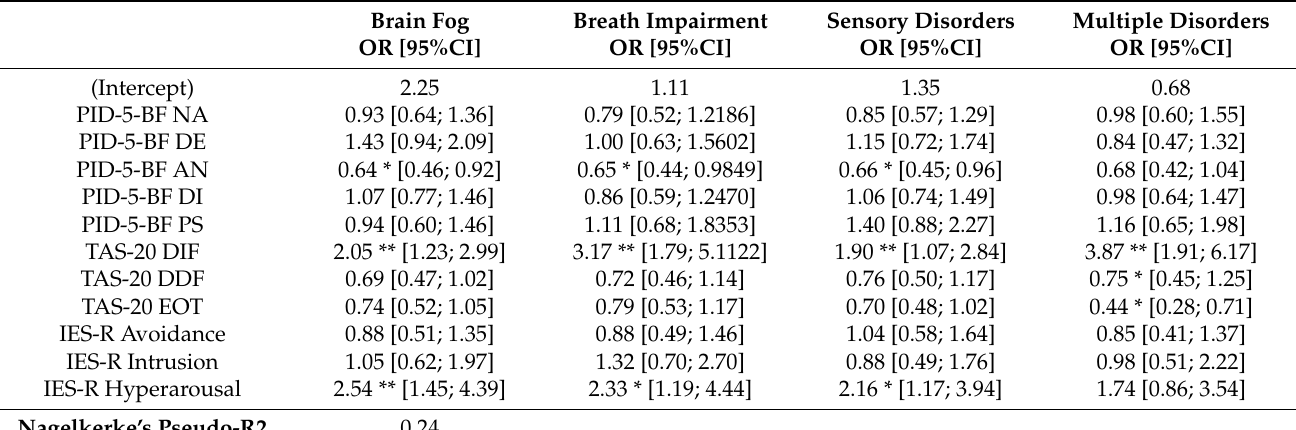
Table 5. Odds ratio from the multinomial logistic regression model for the post-COVID-19 symptom classes ( N =